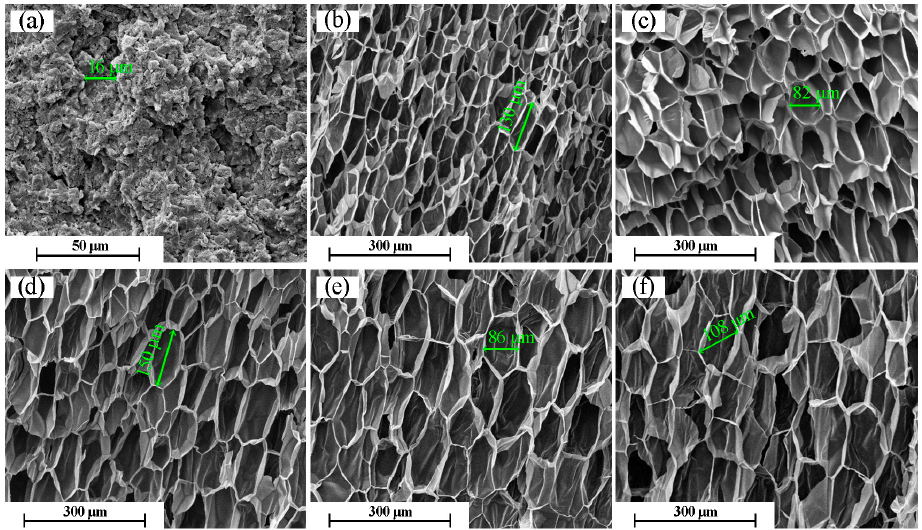
Figure 8. Effect of the foaming temperature on the cell morphology of the PP/TAIC (2 wt %) at 20 MPa (30 kGy). Foaming temperature: ( a ) 146 °C; ( b ) 148 °C; ( c ) 150 °C; ( d ) 152 °C; ( e ) 154 °C; and ( f ) 156 °C.